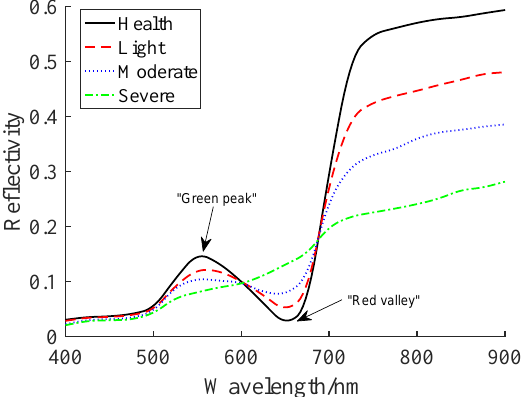
Figure 12. Spectral characteristics of wheat under different degrees of